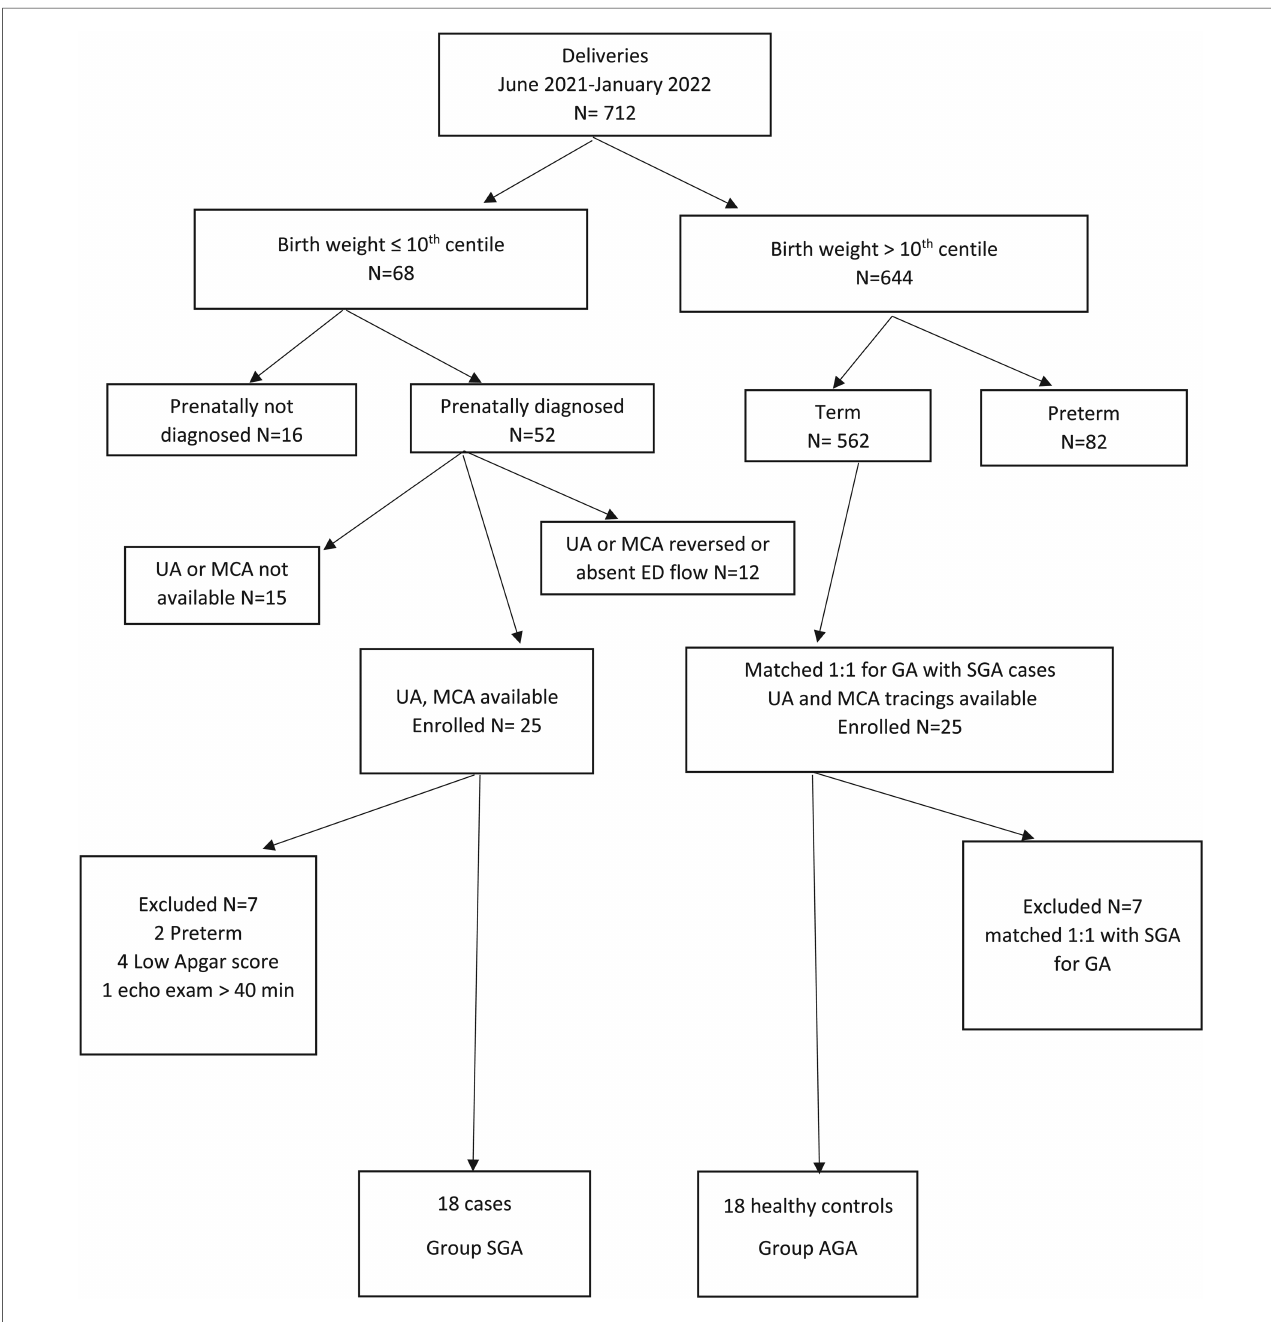
FIGURE 1 Recruitment fl owchart for study